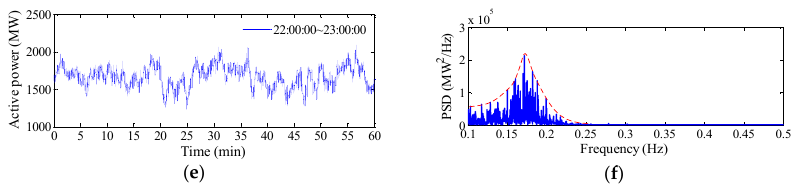
Figure 2. Properties of the UHV tie line oscillations. ( a ) Time-domain curve of the measured oscillation from 04:00:00 to 05:00:00 and ( b ) its corresponding PSD; ( c ) Time-domain curve of the measured oscillation from 10:00:00 to 11:00:00 and ( d ) its corresponding PSD; ( e ) Time-domain curve of the measured oscillation from 22:00:00 to 23:00:00 and ( f ) its corresponding PSD. According to the analysis above, the UHV tie line oscillations mainly have four features, i.e.,